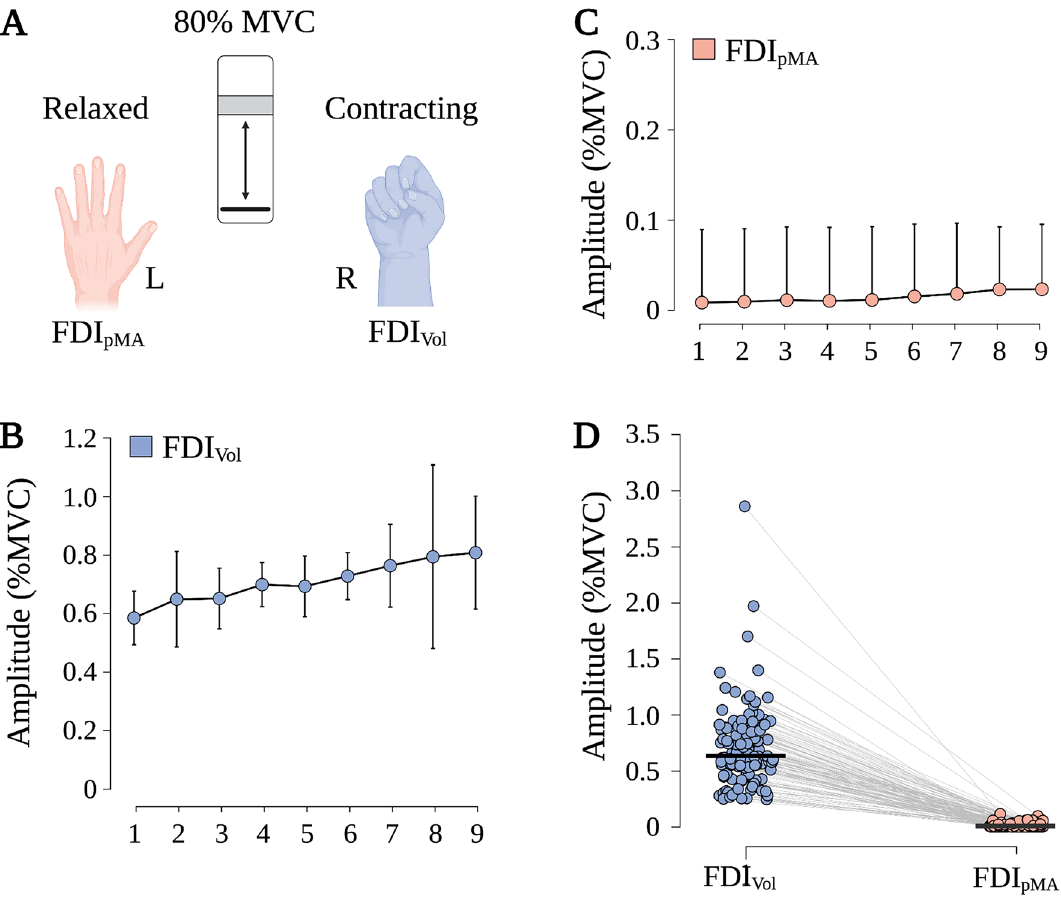
Figure 1. Experimental setup and amplitude of sEMG for FDI Vol and FDI pMA . ( A ) Participants performed a unilateral force generation task. Therefore, the actively contracting (right) hand was used to operate a custom- built force sensor to perform an isometric pinch-task for which the thumb and index finger applied force to the force sensor while the resting (left) hand remained relaxed. ( B ) Average MVC-normalized amplitude of FDI Vol of all participants and for all blocks (mean ± 95% confidence interval). ( C ) Average MVC-normalized amplitude of FDI pMA of all participants for all blocks (mean ± 95% confidence interval). ( D ) Raincloud plot of MVC- normalized amplitudes of all 3 s contractions (14 participants × 45 contractions) for FDI Vol and FDI pMA . Note the subliminal nature of pMA with amplitudes that are only a fraction of the amplitude of the actively contracting muscle. The black horizontal bar represents the mean. Created with as well as the force required to reach it, were adjusted to individual maximum voluntary force values, represent- ing 80% of maximum force. A maximum force test was performed separately for both the right and left hands before the test. Participants exerted an individual maximum contraction 3 times (5 s duration for each repetition) with a resting period of 1 min between contractions to counteract fatigue and prevent injuries. The trial where participants exerted the highest force was taken as their individual maximum force. This trial was further used for the normalization of individual force levels during the behavioral task. The corresponding EMG amplitude to this trial was then taken as the individual maximum voluntary contraction (MVC) for further EMG MVC normalization. For this purpose, EMG activity over a window of 500 ms around the peak of the maximum contraction was averaged. The subsequent task used a block design consisting of a constant force level (80% of individual maximum force). Five isometric contractions were performed using the right hand within one block. One contraction lasted for 3 s, with 3 s of rest between contractions. As all participants performed 5 contractions per block, this resulted in a total duration of 30 s per block. Each block was followed by a resting period of 4:30 min to allow partial recovery. In total, each participant completed 9 blocks. Taken together, the time to finish the task was 45 min. EMG recordings and analysis. sEMG was recorded on a wireless Desktop Direct Transmission System (NORAXON Inc., Scottsdale, USA). EMG signals were obtained from bilateral first dorsal interossei muscles (FDI) using bipolar surface electrodes (Ag/AgCl; diameter: 10 mm). Inter-electrode distances were consist- ent at 20 mm and electrodes were attached in parallel to muscle fiber orientation. This configuration allowed us to record sEMG activity over the voluntarily contracting FDI (FDI Vol ), as well as subliminal pMA over the homologous FDI (FDI pMA ) of the relaxed hand. EMG data were recorded with a sampling frequency of 1500 Hz,